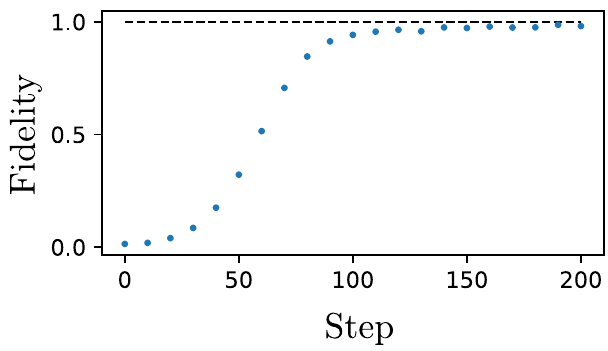
FIG. 5. Quantum state tomography of the beryllium hydride molecule. We show the fidelity F = |(cid:5) (cid:10) | ψ θ (cid:2)| 2 between the neural-network wave function ψ θ and the exact molecular wave function (cid:10) at each iteration during